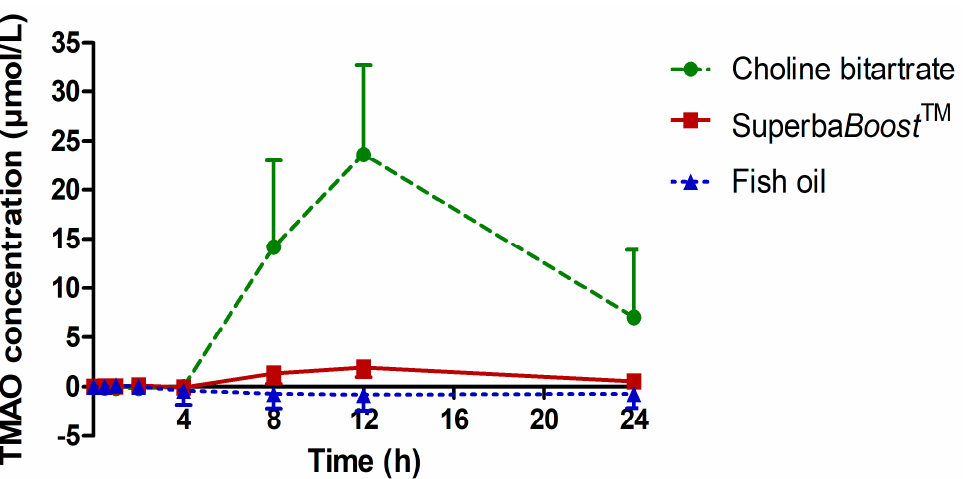
Figure 5. Plasma concentration–time curve of TMAO. Values are baseline-corrected. Choline bitartrate: